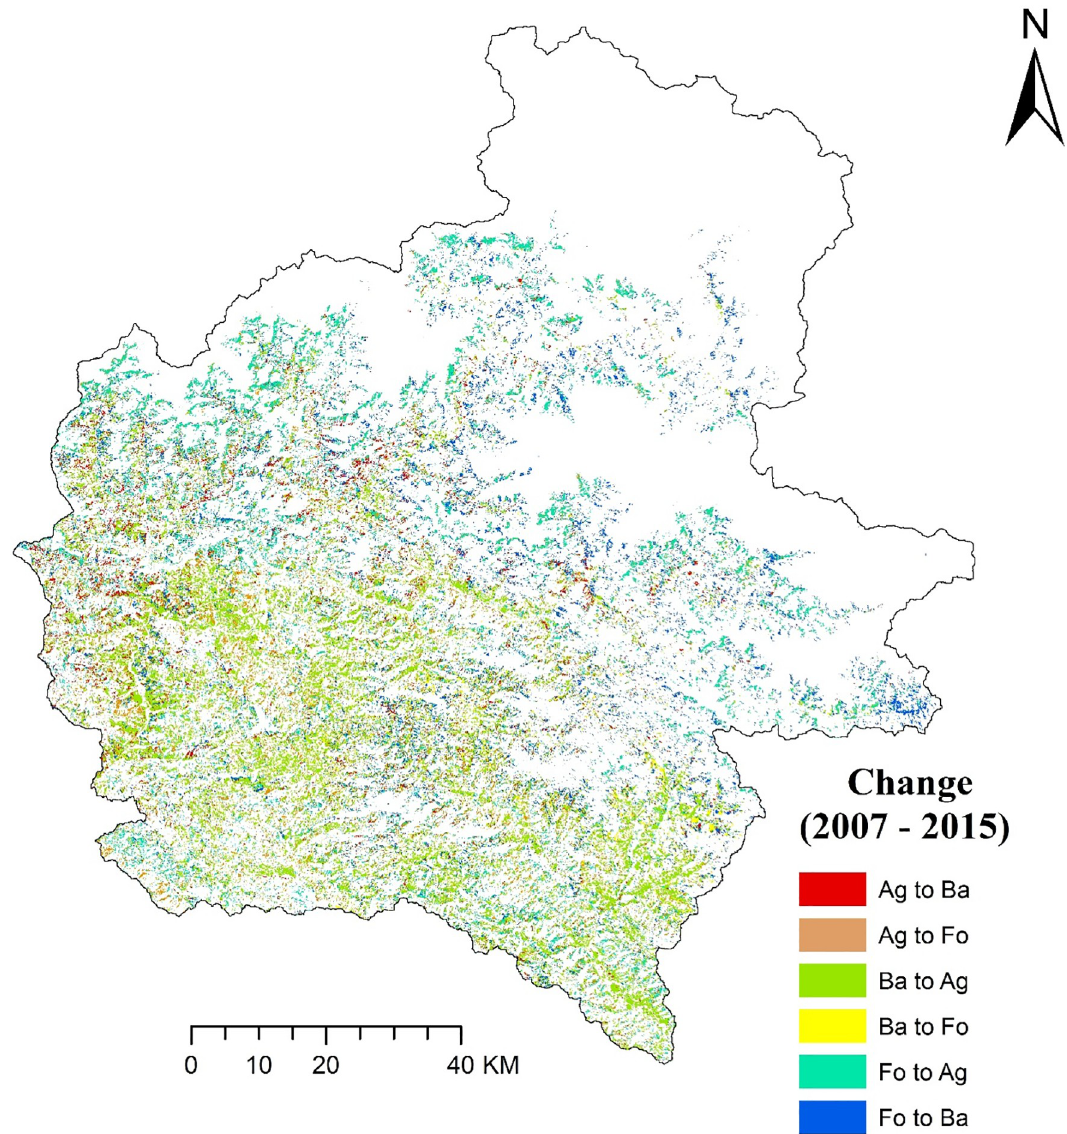
Fig 5. Change analysis thematic map showing land use conversion from 2007 to 2015 (Ag = Agriculture, Ba = Barren land, Fo = Forest).